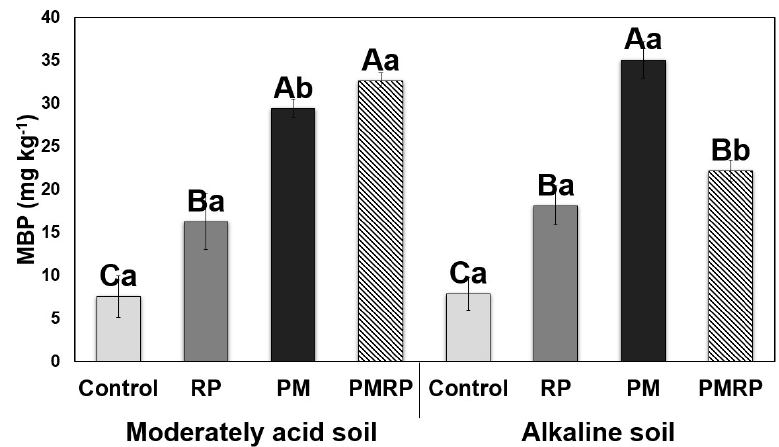
Figure 2. Microbial biomass phosphorus (MBP) in in control and soil amended with poultry manure compost (PM), phosphate rock (RP), and their combination (PMRP) after 7 weeks of ryegrass growth. Upper case letters denote significant di ff erences ( p ≤ 0.05) between treatments for one soil. Lower case letters denote significant di ff erences ( p ≤ 0.05) between soils for one